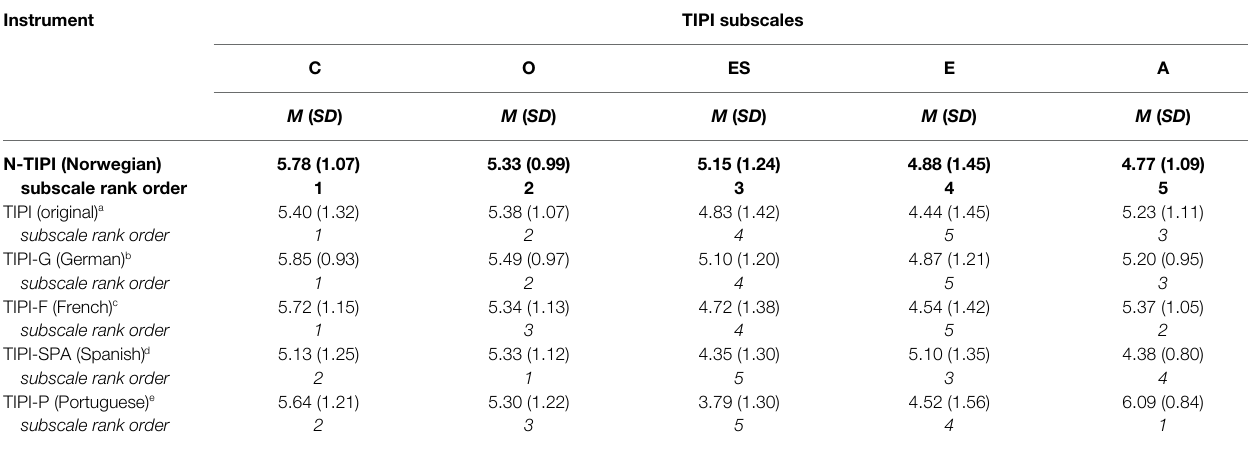
TABLE 4 | Descriptive statistics (means and standard deviations) and rank order of means for the TIPI subscales, N-TIPI compared with the original TIPI and four other versions.